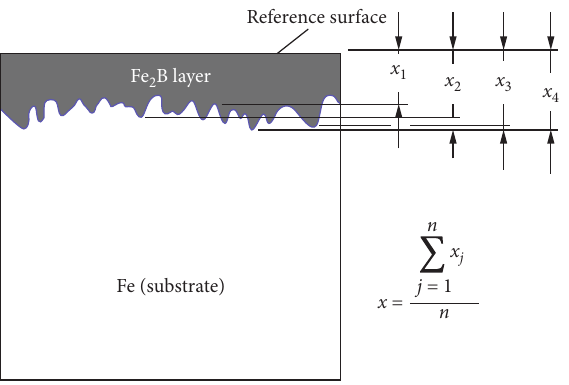
Figure 3: The procedure for estimation of Fe AISI W2